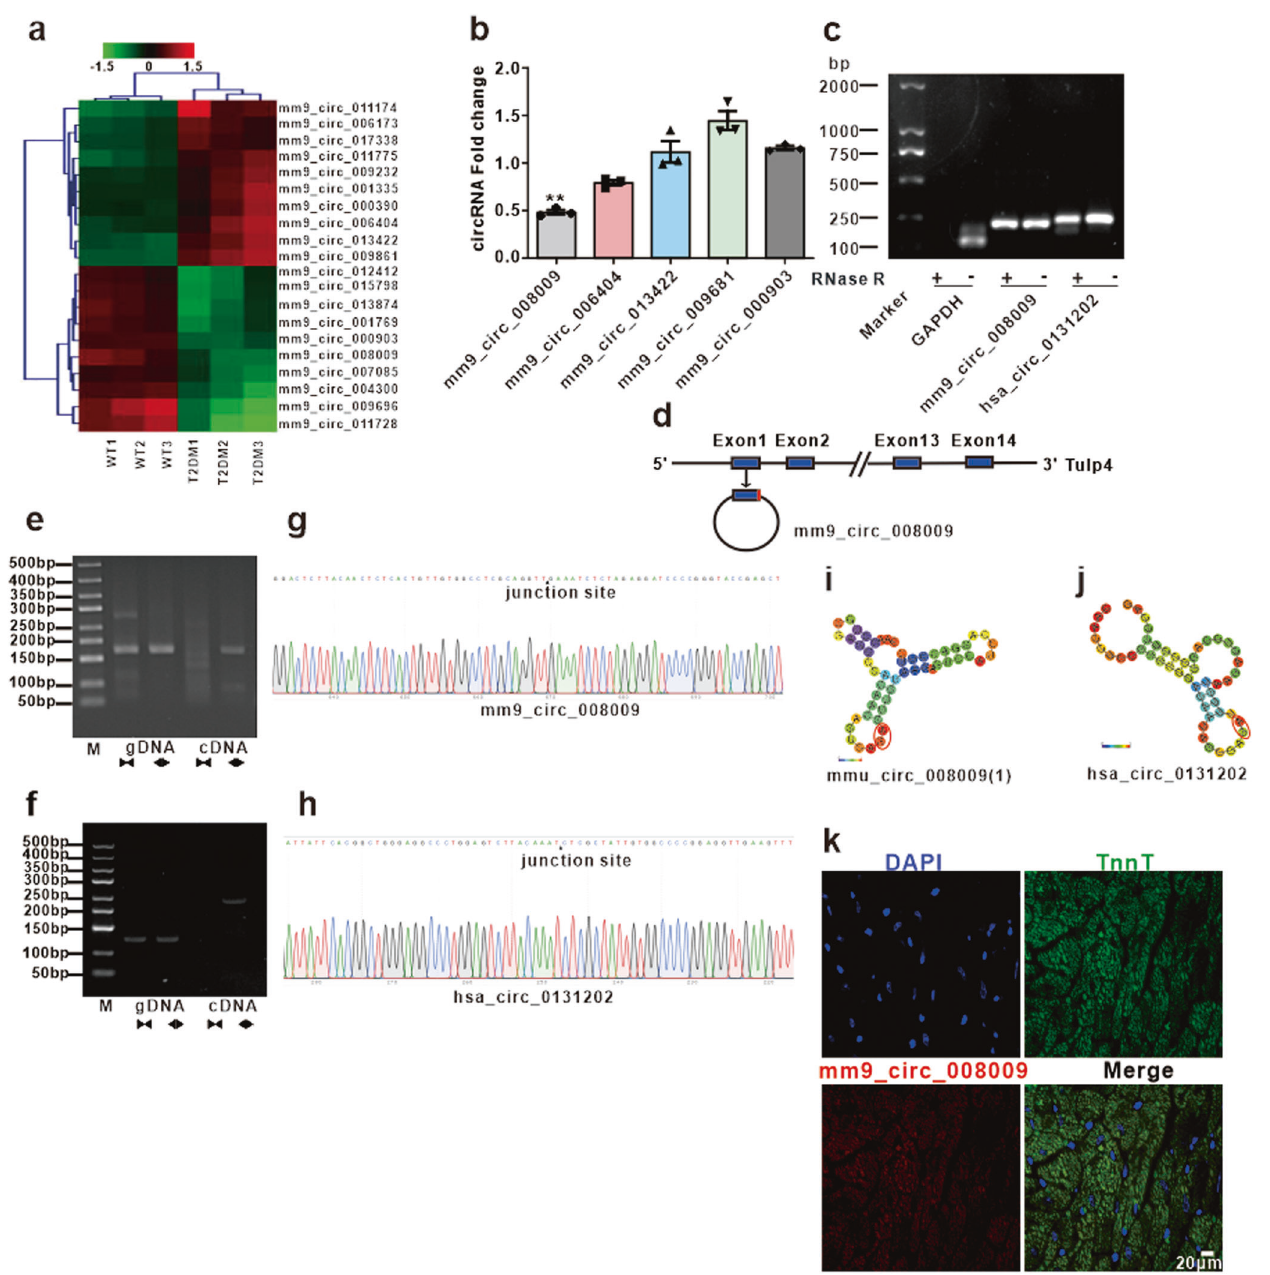
Fig. 1 Identi fi ed circRNA expression in diabetic cardiomyopathy mouse. a Microarray identi fi ed in the hearts of db/db mice. b Select signi fi cantly regulated circRNA detected by qPCR ( n = 9). c CircRNA resistance detected by RNAse. d Mm9-circ-008009 structure. e Identi fi cation of the mm9-circ-008009 back-spliced junction sites. f Identi fi cation of the hsa-circ-0131202 back-spliced junction sites. g , h Sanger sequence of mm9-circ-008009 and hsa-circ-0131202. i , j Second structure prediction of mm9-circ-008009 and hsa-circ-0131202. k FISH detection of mm9-circ-008009 in the mouse heart tissues. Data are represented as mean ± SEM. ** P < 0.01 vs . WT